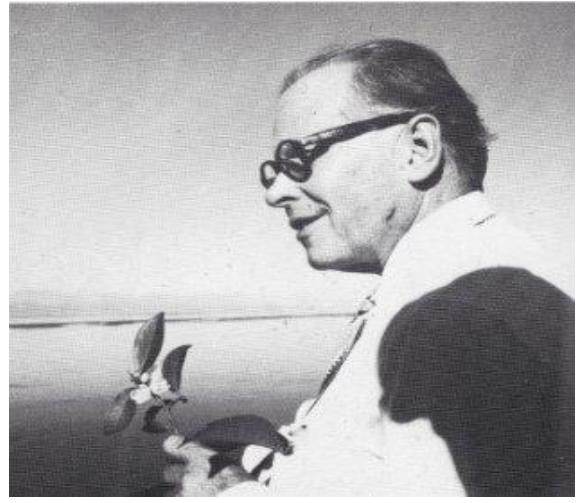
Figure 5. Mrs. Wilson and sons Philip, left, and Stephen, right, enjoying the Dibru River.